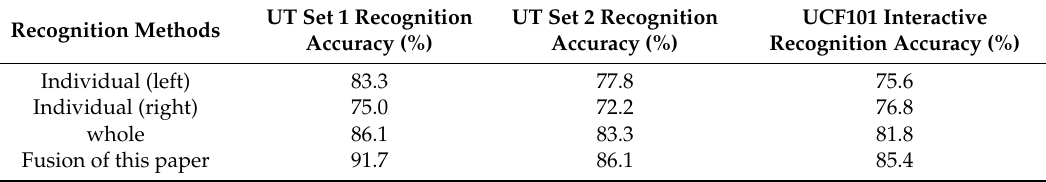
Figure 13. Classification results of human interaction based on whole–individual detection. Table 2. Comparison of the individual video and whole video recognition